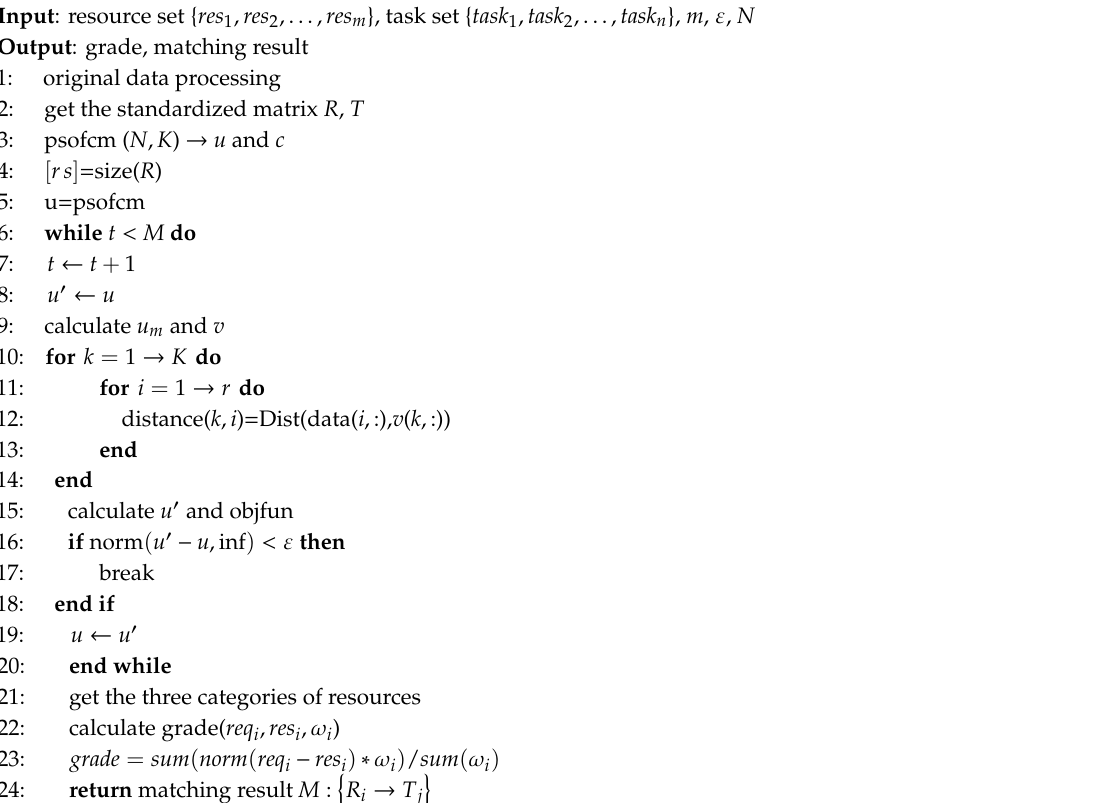
Algorithm 1 : resource scheduling algorithm based on